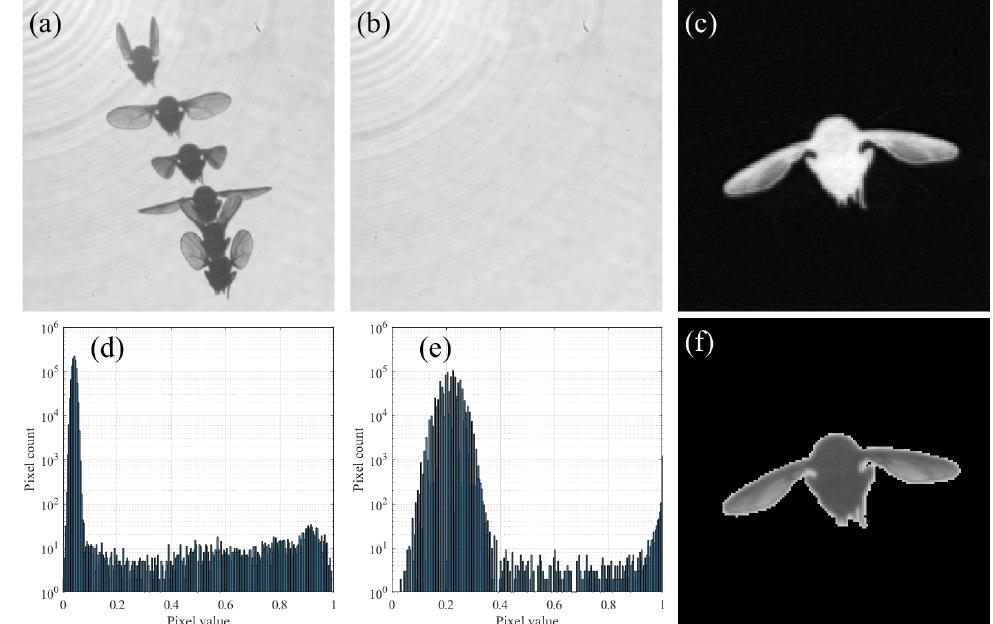
Figure 3. Pre-processing of free flying videos. ( a ) Superimposition of 6 raw images mid flight. ( b ) Background extracted by taking pixel-wise maximum. ( c ) Subtraction of a single frame from the background. ( d ) Histogram of subtracted image. The distribution is almost uni-modal. ( e ) Histogram of subtracted image after power transformation. Distribution is more bi-modal. ( f ) Resulting mask after applying Otsu’s threshold on transformed difference